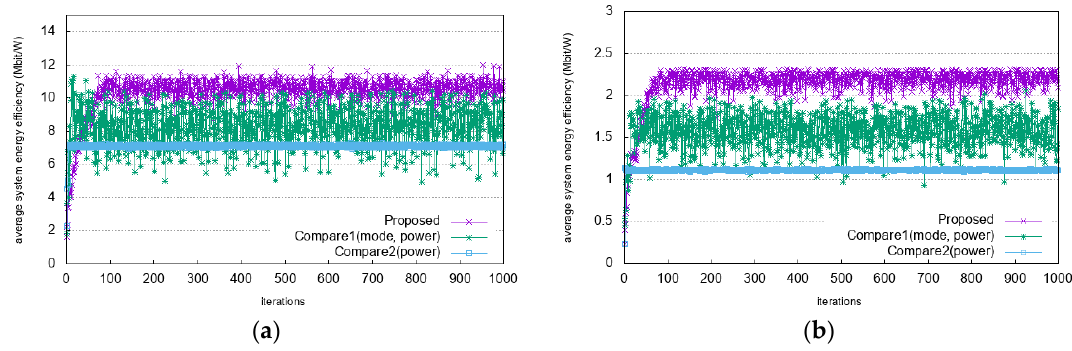
Figure 6. Convergence of system energy efficiency as a reward function with D2D distance = 350 m: ( a ) light traffic scenario; ( b ) heavy traffic scenario.